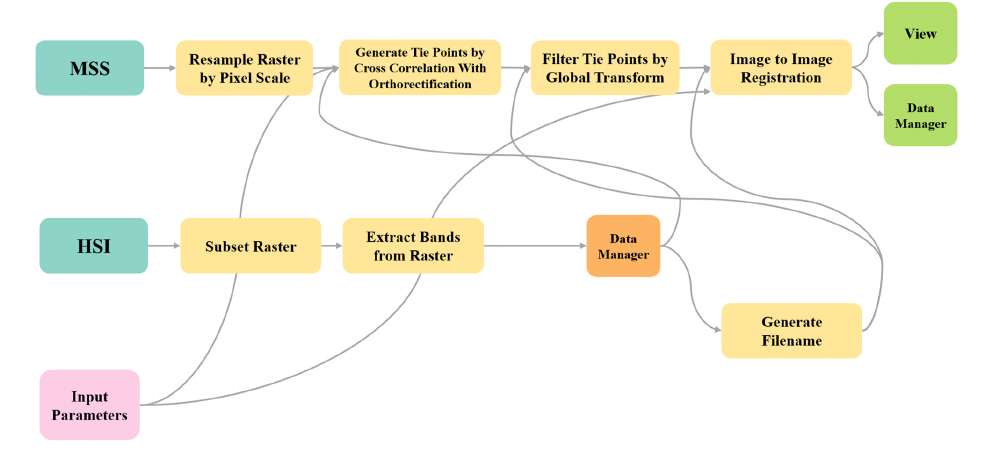
Figure 5. Our modeling flow by ENVI